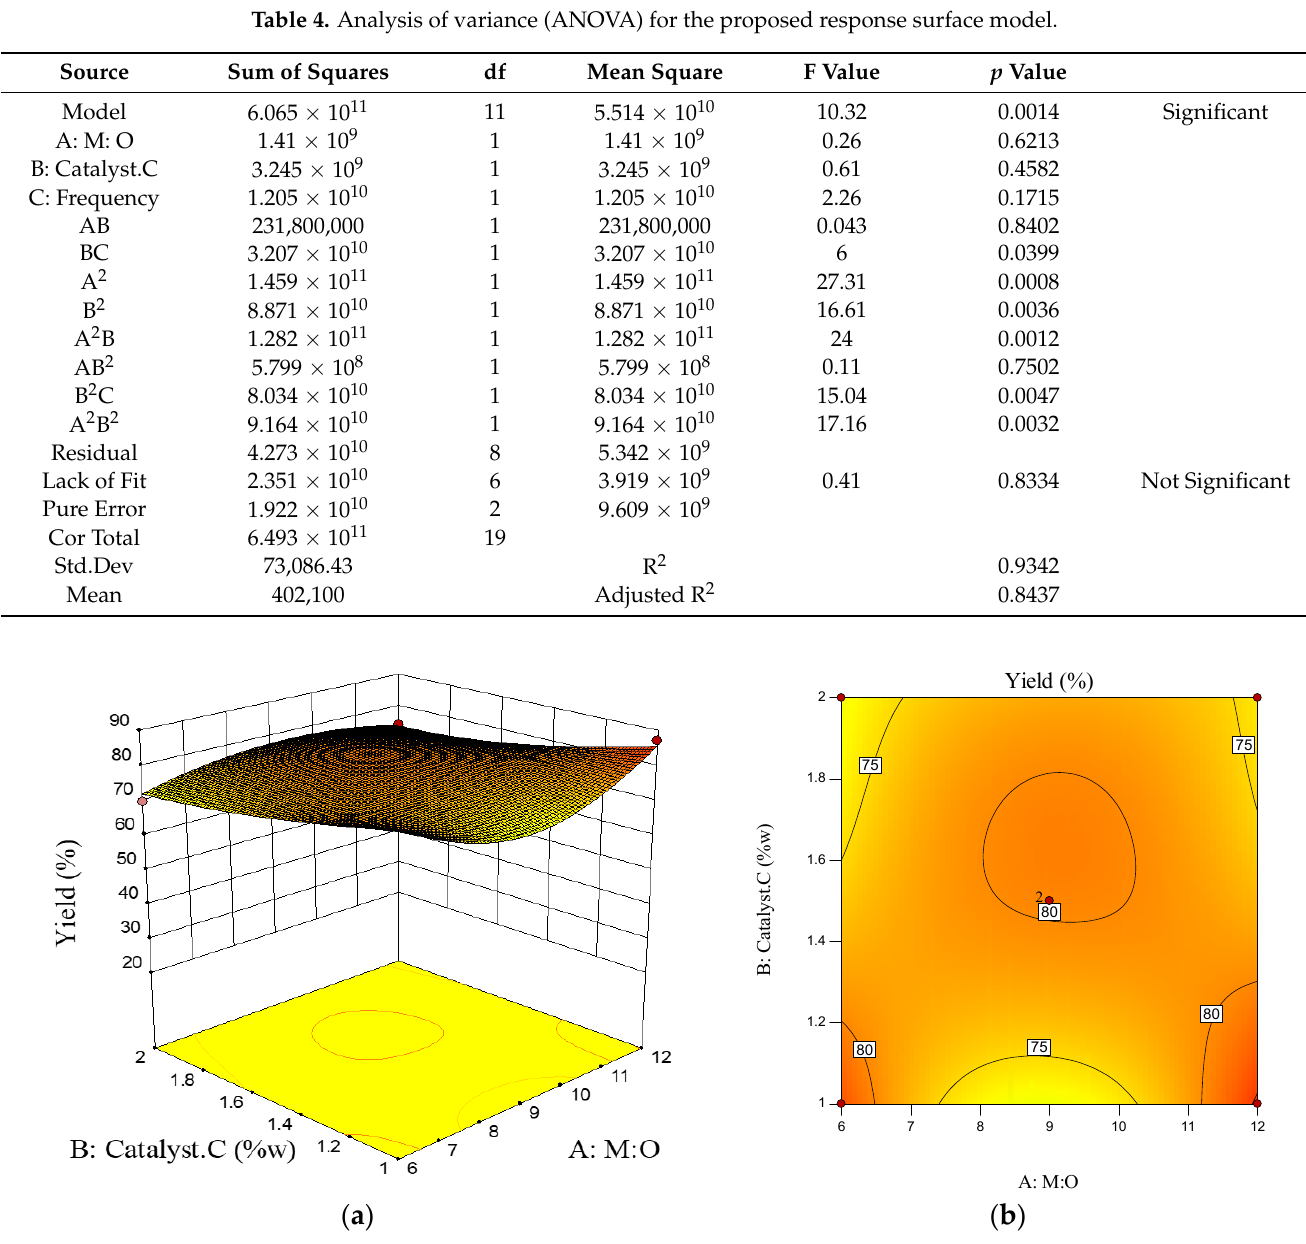
Figure 5. The effect of KOH catalyst amount, methanol-to-oil molar ratio, and their reciprocal interaction on chicken feet oil biodiesel synthesis using the 25 kHz ultrasonic frequency, ( a ) response surface 3D plot, ( b ) contour plot.